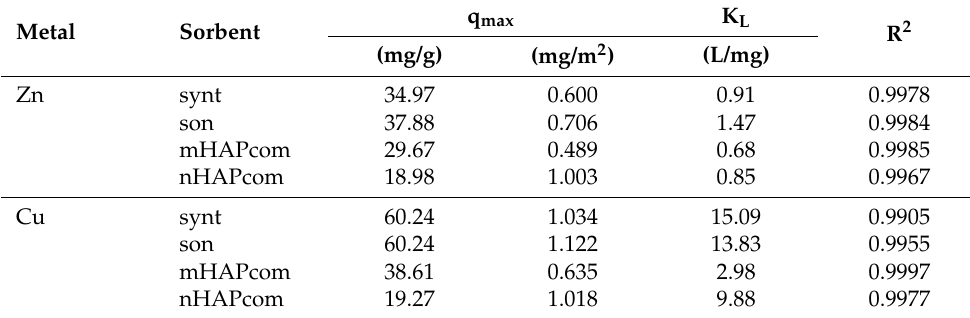
Table 3. Summary of obtained Langmuir adsorption parameters.